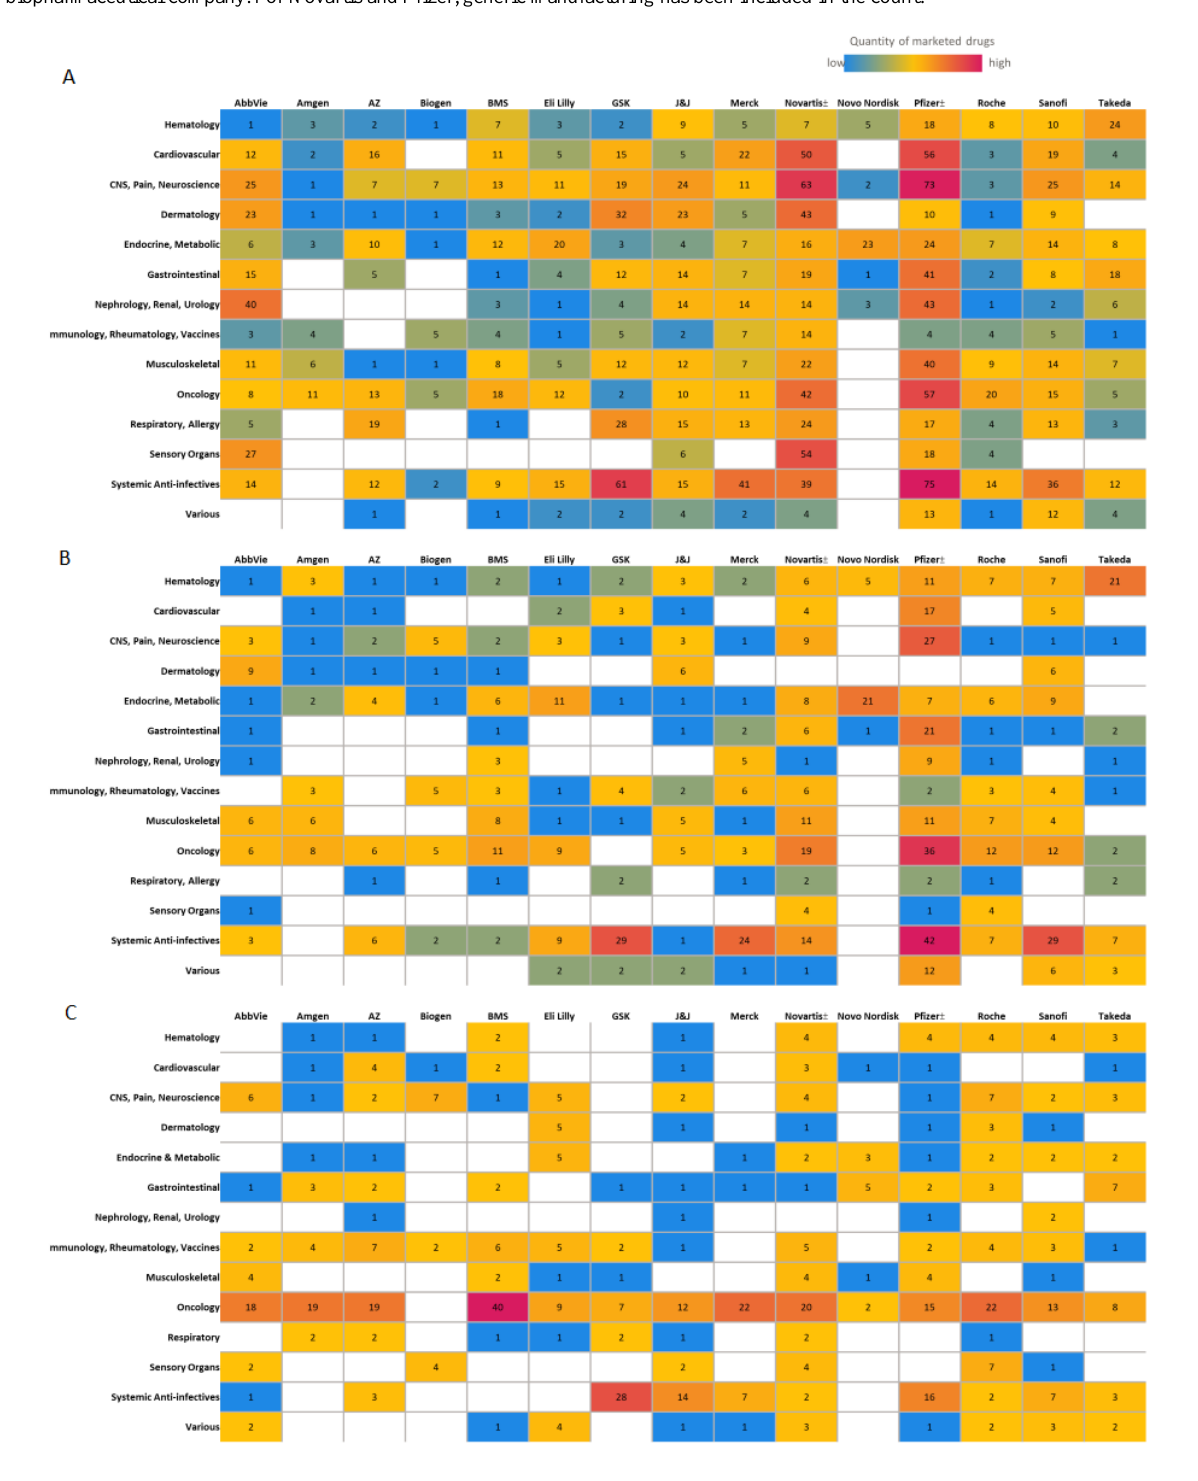
Figure 3. Biopharma portfolios and pipeline by therapeutic areas. Heatmaps showing (A) marketed molecules across all routes of administration, (B) marketed injectable molecules, and (C) phase I to III pipeline molecules proposed for injectable administration. Biopharma pipeline assessment for the US market was conducted via the EvaluatePharma database as of October 1, 2020. Therapeutic areas defined in this paper were standardized across each biopharmaceutical company. For Novartis and Pfizer, generic manufacturing has been included in the